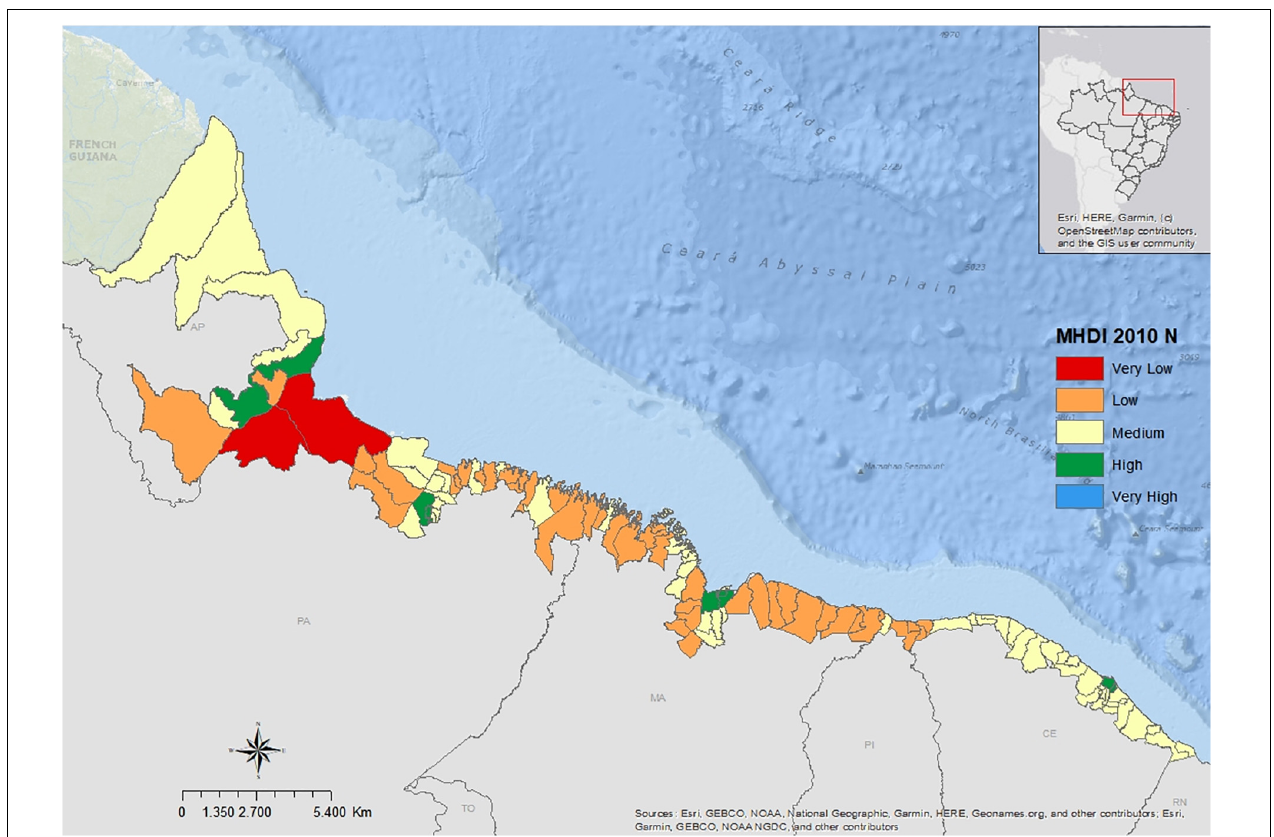
FIGURE 2 | MHDI for the North coast municipalities. Elaborated by the authors with data from PNUD et al.